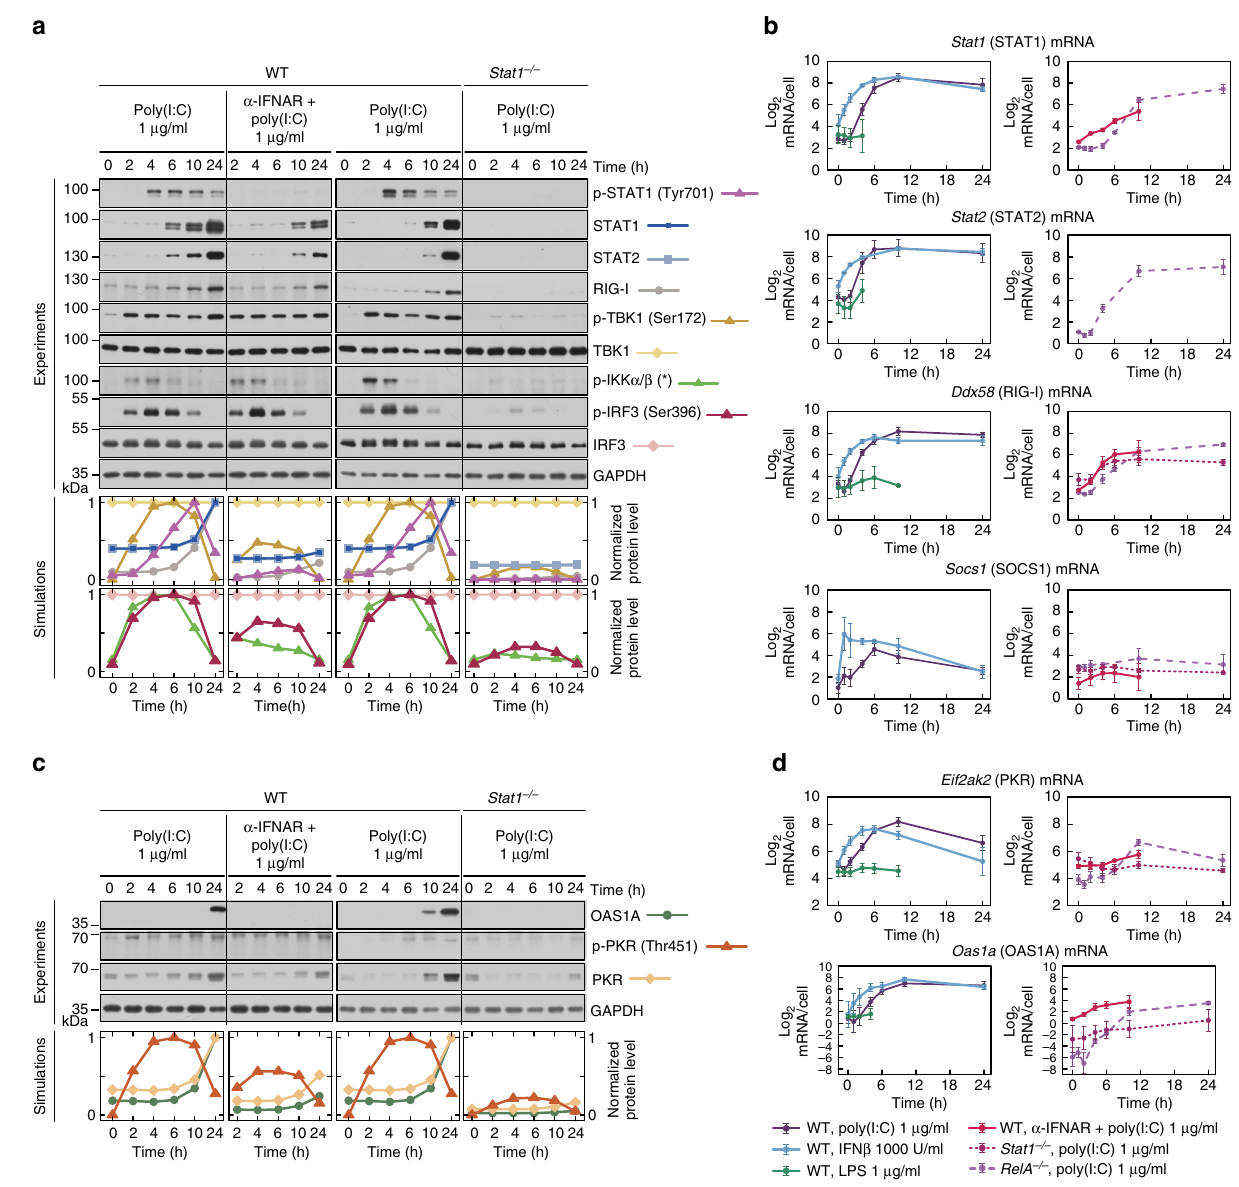
Fig. 4 Paracrine regulation via the JAK/STAT pathway. a , c Protein levels of the pathway components in response to 1 μ g/ml poly(I:C), characterised by western blotting and numerical model simulations. In separate experiments WT MEFs were stimulated with poly(I:C) in the presence of α -IFNAR, and Stat1 – / – MEFs were stimulated with poly(I:C), for the indicated times. For each experiment, its control, poly(I:C)-stimulated WT MEFs, is included. Whole- cell extracts were analysed. Representative replicates out of 3 are shown. Trajectories show averages of over 200 independent stochastic simulations; the colour key is located next to protein labels. a Mediators of positive feedback were analysed using antibodies against phosphorylated (active) forms of STAT1 (p-Tyr701), TBK1, IKK α / β and IRF3 (p-Ser396), as well as total STAT1, STAT2, RIG-I, TBK1, and IRF3. (*) = IKK isoform-dependent phosphorylation sites: p-IKK α Ser176/180, p-IKK β Ser 177/181. c STAT1/2-regulated mediators of double negative feedback were analysed using antibodies against total OAS1A and PKR, as well as for a phosphorylated (active) form of PKR (p-Thr451). b , d mRNA levels of STAT1/2-regulated genes, Stat1 , Stat2 , Ddx58 (RIG- I), Socs1, Eif2ak2 (PKR) and Oas1a , in response to LPS, IFN β or poly(I:C). WT MEFs were stimulated with 1000 U/ml IFN β , 1 μ g/ml LPS or 1 μ g/ml poly(I:C) in the absence (left) or presence (right) of IFNAR-blocking antibody ( α -IFNAR). Stat1 – / – MEFs and RelA – / – MEFs (right) were also stimulated with 1 μ g/ml poly(I:C). Time pro fi les of relative mRNA levels were obtained with RT-PCR, and then rescaled to absolute numbers using digital PCR measurements (bars represent means ± s.e.m., n ≥ 2, see Supplementary Note for plots of all replicates compared with model